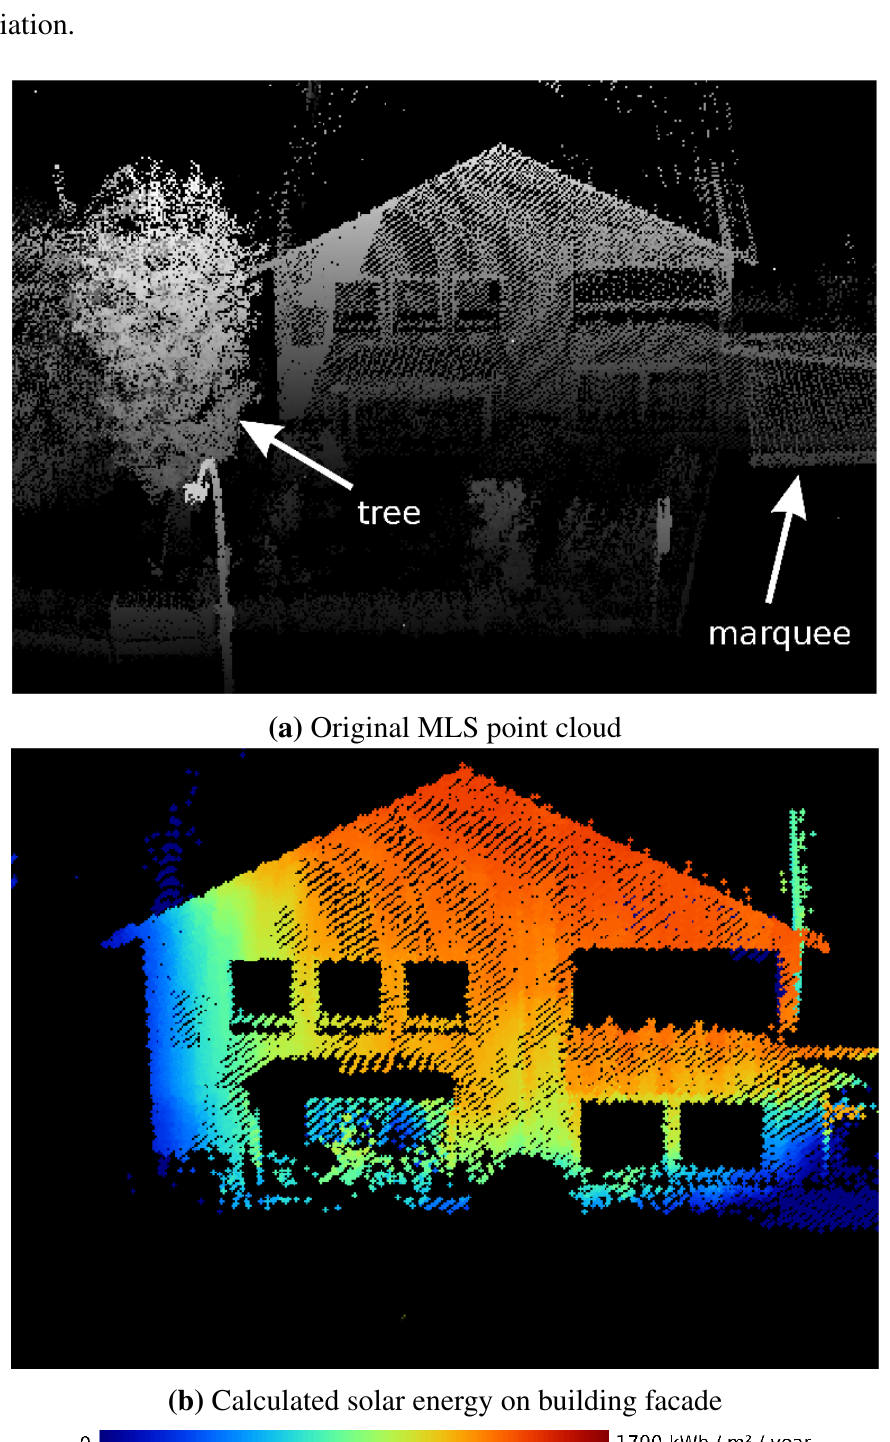
Figure 10. Incoming solar energy on a west southwest orientated building facade is shown. Shadows casted by a nearby tree and a marquee, respectively, result in areas receiving less solar